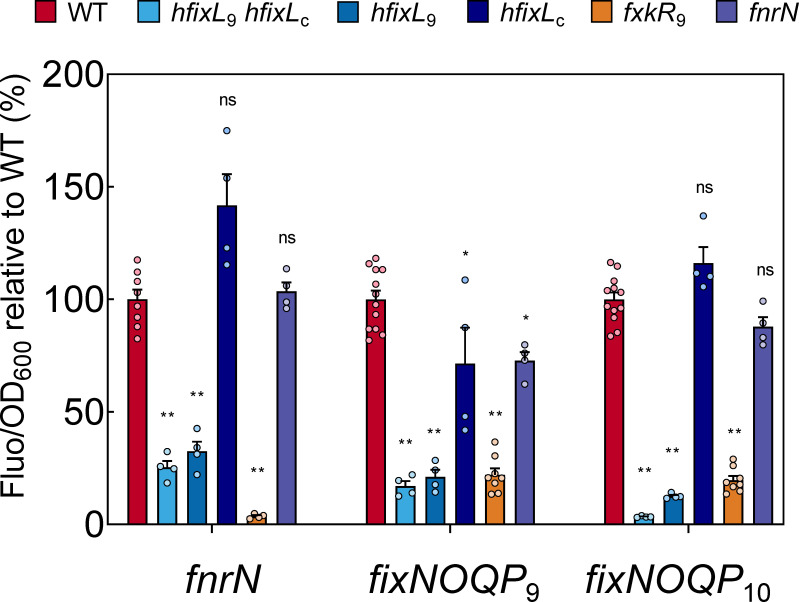
Under microaerobic (1% O2) conditions in free living cells, the hFixL-FxkR-FixK pathway and not FnrN is a key activator of anaerobox controlled genes.Plasmids with promoter fusions to syfp2 for fnrN (pOPS0980), fixNOQP9 (pOPS0978) and fixNOQP10 (pOPS0977) were conjugated into Rlv3841 WT and O2 regulation mutants (hfixL9
hfixLc, LMB496; hfixL9, LMB495; hfixLc, LMB403; fxkR9, OPS1808; fnrN, LMB648). Fluorescence and OD600 measurements were taken after cells were grown under microaerobic conditions (1% O2). Individual values (Fluo/OD600) are normalised such that the WT average is 100% for each reporter group. Activity from all three promoters was critically reduced or nearly abolished in the double hfixL and fxkR mutant backgrounds. The hfixL9 homolog had a far more pronounced effect on expression of all three genes than did the hfixLc homolog. Little or no reduction in expression was observed when fnrN was mutated. Data are averages (±SEM) from at least four biological replicates. Statistical tests are differences relative to WT expression; ns (no significant decrease) P ≥ 0.05; *P < 0.001; **P < 0.0001; by one-way ANOVA with Dunnett’s post-hoc test for multiple comparisons.